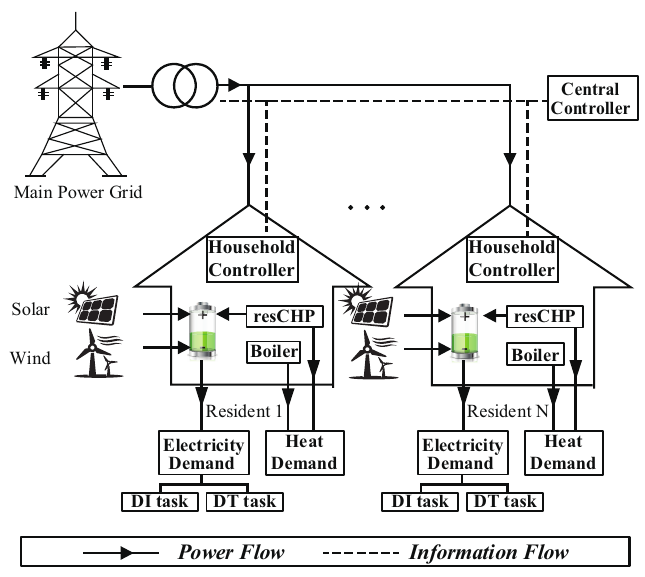
Figure 1. The structure of a system